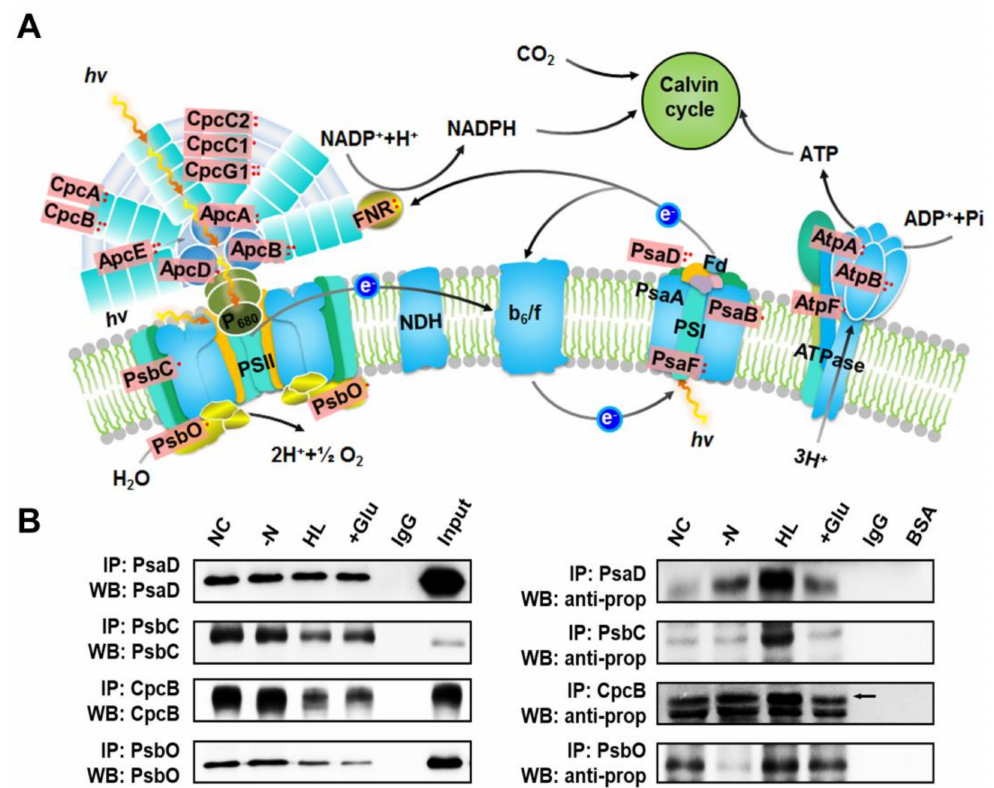
Figure 5. Overview of the lysine propionylation events involved in photosynthesis in Synechocystis . ( A ) Illustrations of propionylated proteins involved in the photosynthesis process. The identified propionylated proteins are highlighted in light red. ( B ) Verification of propionylated proteins associated with photosynthesis using immunoprecipitation and western blotting. NC: normal condition, -N: nitrogen deficiency, HL: high light condition, + Glu: glucose condition, Input: total cell